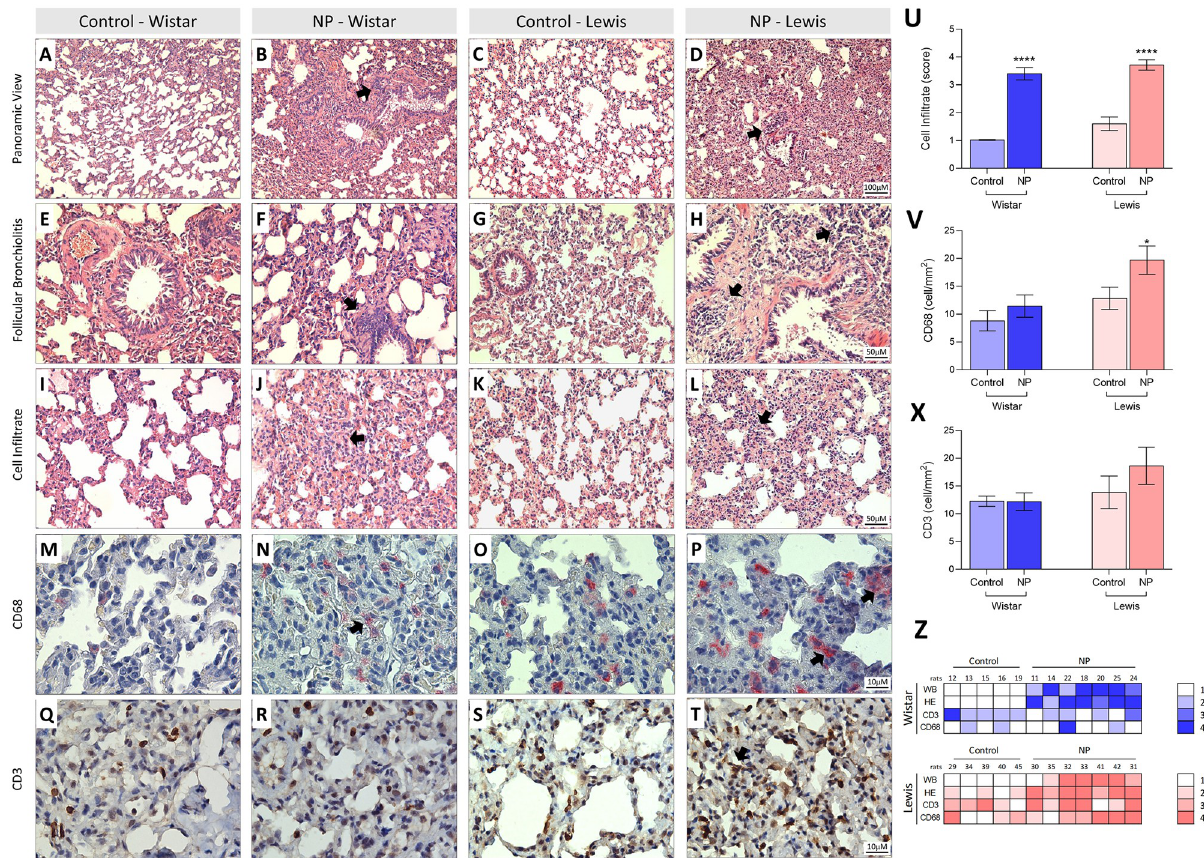
Fig 4. Histological assessment and immunohistochemistry in lung tissue stained with HE (A-L) and immunostaining by CD68 and CD3 (M-T) . In A and C the lung parenchyma presents normal appearance, as well as regular alveolar septa and vessels in the Wistar and Lewis Control group. In contrast, in B and D we identified distortion of pulmonary histoarchitecture and intense thickening in the alveolar septa region with the presence of cellular infiltrate and collagen deposition around the septa in the NP Wistar and Lewis groups (Arrows). Note in F and H the follicular bronchiolitis with the presence of intense lymphocytic infiltrate in the NP Wistar and Lewis groups when compared to the respective controls ( E and G ). Observe in J and L the thickening of pulmonary interstitium of the NP Wistar and Lewis groups (arrows) when compared to the controls group ( I and K ). In N we identified in pinkish red the immunostaining for CD68 in the pulmonary interstitium of the NP Wistar group, showing a slight number of cells positive for CD68 and when compared with its respective control (M) . In contrast, we observed an increase in cells immunostained for CD68 in lung parenchyma of NP Lewis group (P) when compared to its control group (O) . In R , note in brown the immunostaining for CD3 lymphocyte in the lung parenchyma NP Wistar group, when compared to the control group (Q) and in T , we identified CD68-positive cells in the thickening of pulmonary interstitium and control (S) . In (U) , graphical representation of the score for inflammatory cells indicate significant increase in NP Lewis and Wistar groups. In (V) CD68 statistical difference in Lewis NP and its control significant expression in alveolar septa and peribronchial region and (X) Graphical representation of CD3 quantification of CD3 in alveolar septa and peribronchial region of lung tissue. In Z , note intensity correlation of the anti-NP antibodies and expression of CD68 and CD3 in lung tissue of NP Wistar and Lewis group.